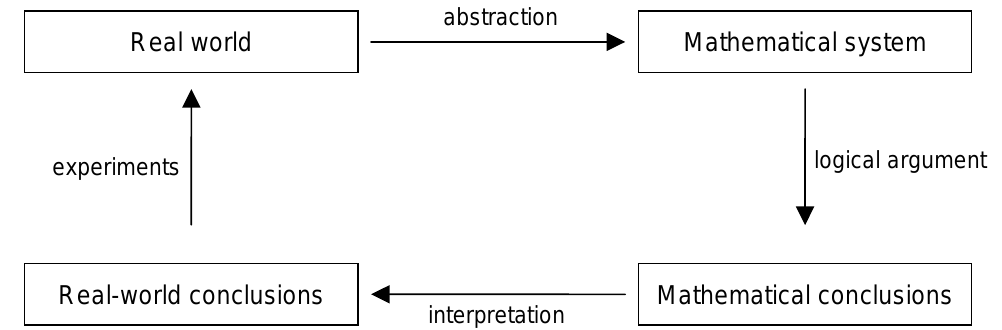
Figure 1. Diagrammatic representation of Olnick’s modelling